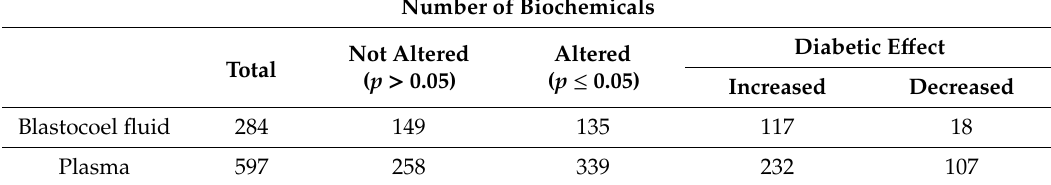
Table 1. Number of biochemicals that were detected and quantified in plasma and blastocoel fluid (BF) of diabetic rabbits by Metabolon ® analysis. Alterations were calculated as fold change of diabetic vs. non-diabetic values. Welch’s two-sample t-test was used to identify biochemicals that di ff ered significantly between experimental groups.